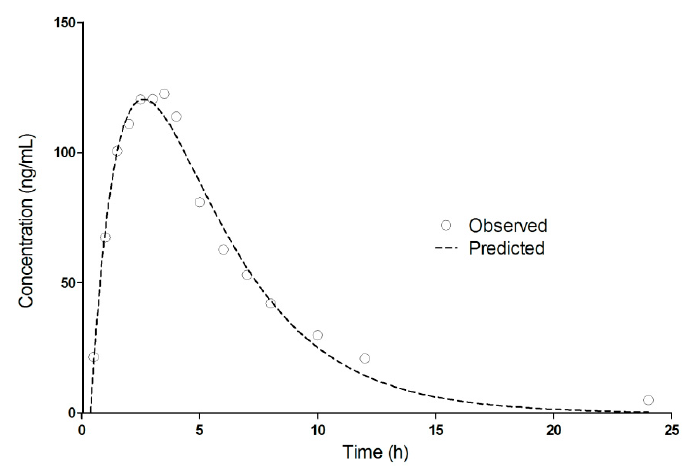
Figure 5. One-compartment pharmacokinetic modeling of DTZ mean plasma levels after oral